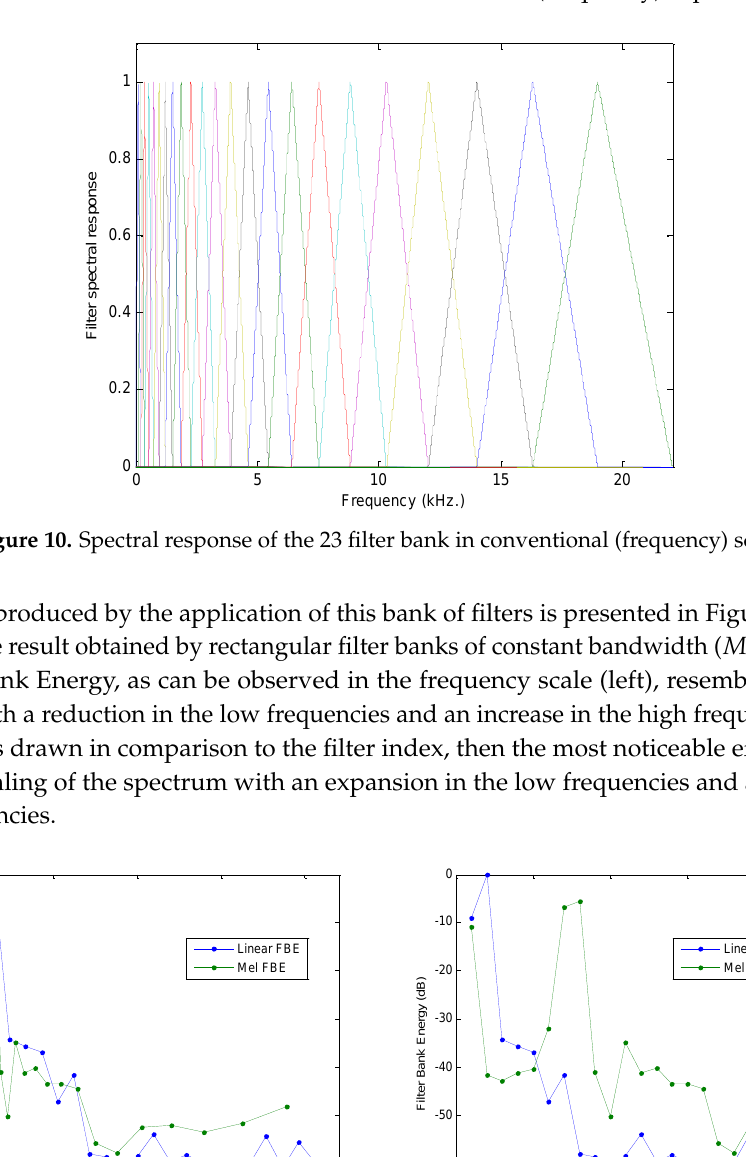
Figure 11. Linear and mel Filter Bank Energy: ( left ) horizontal frequency scale; ( right ) horizontal mel scale (filter index).